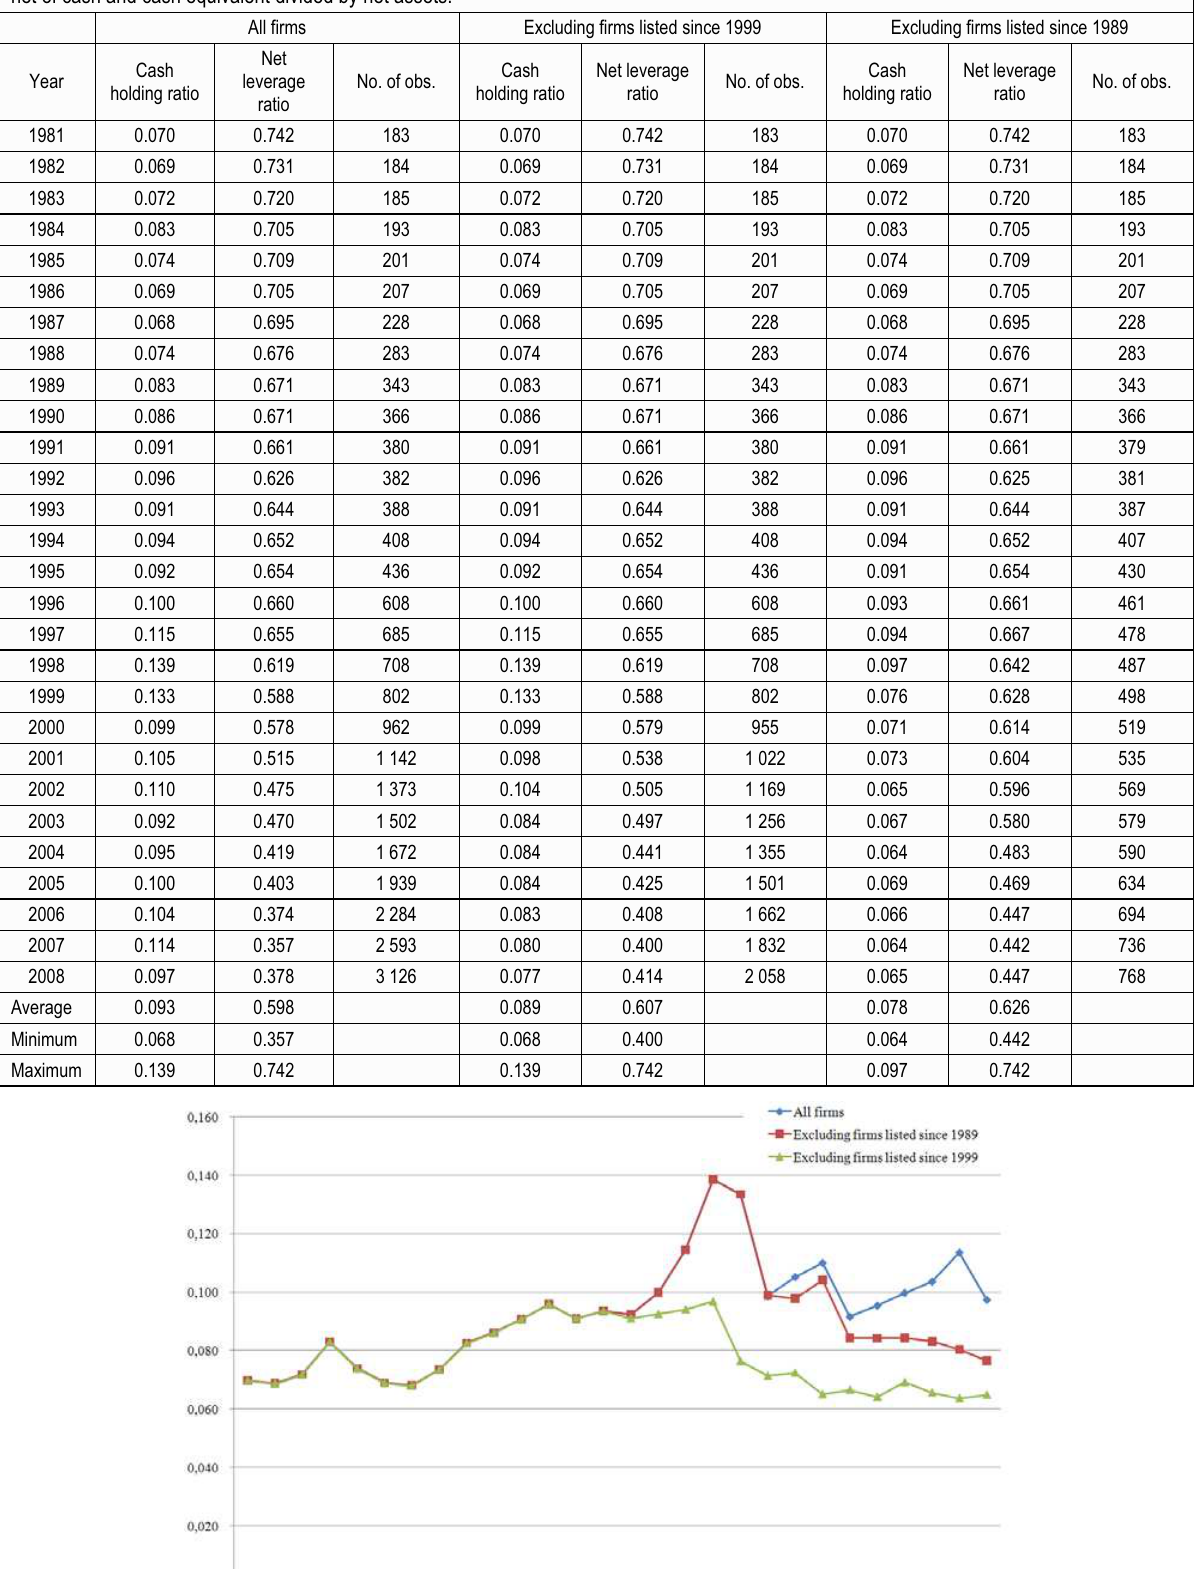
Table 1. Cash holding and net leverage ratios The cash holding ratio is defined as cash and marketable securities divided by total assets. The net leverage ratio is defined as the leverage net of cash and cash equivalent divided by net